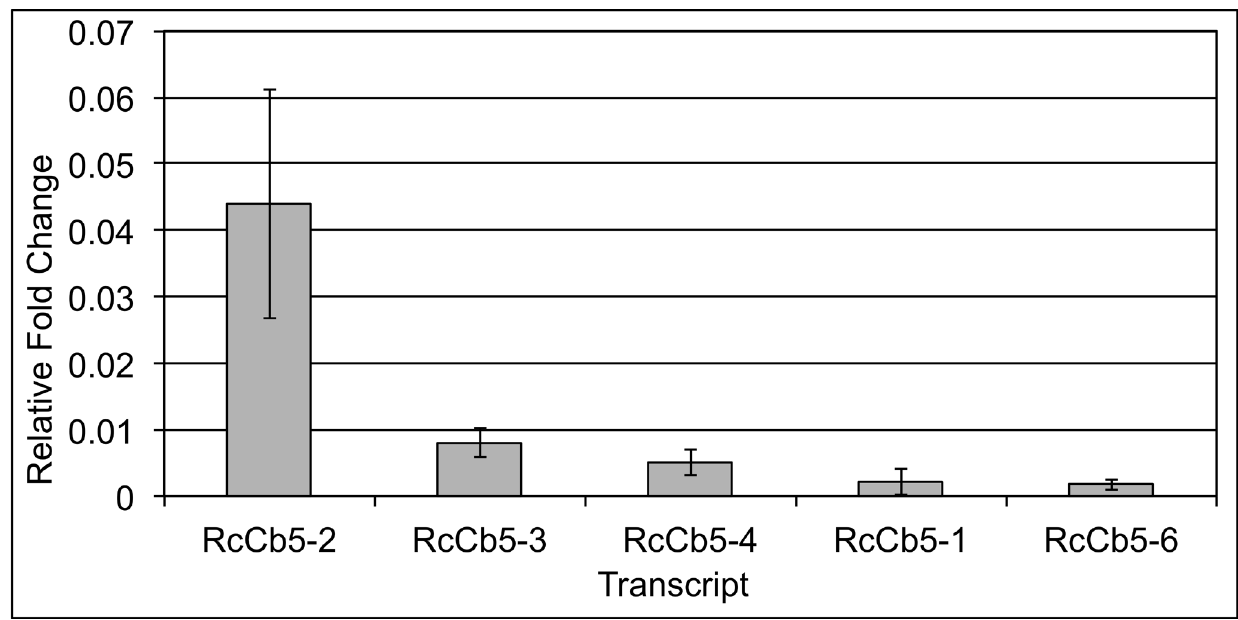
Figure 2. Quantitative PCR of RcCb5 transcripts from developing castor endosperm. Transcripts were normalized to RcACTIN. Error bars represent standard error of the mean of three independent experiments with three replicates for each experiment.